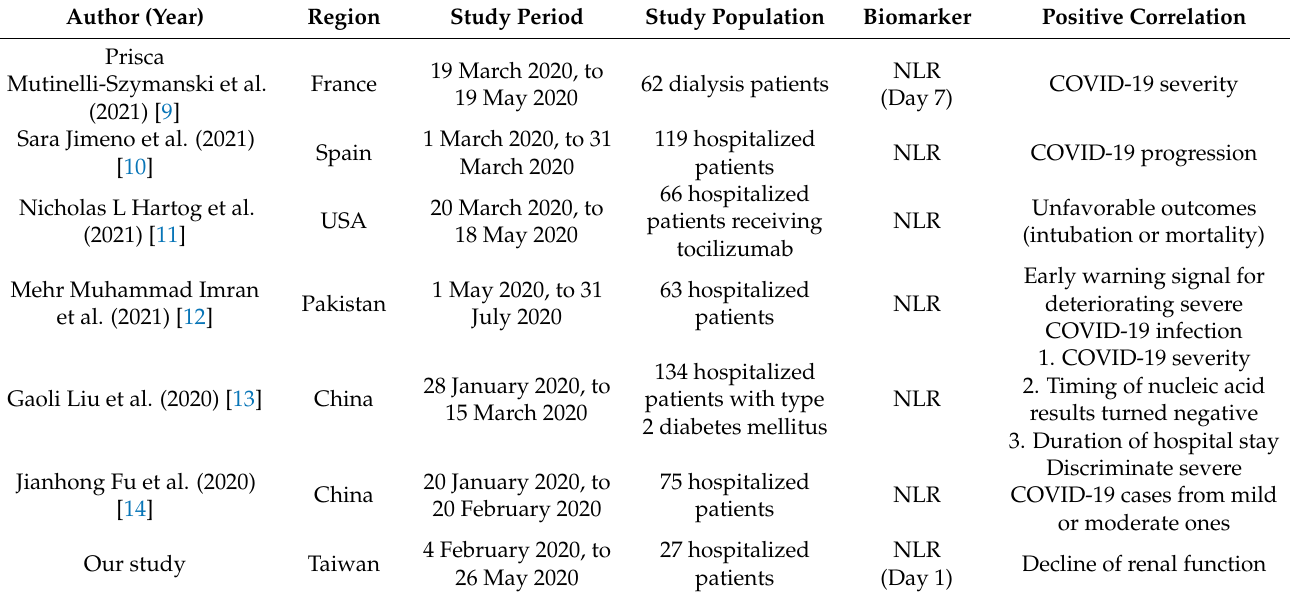
Table 5. The role of NLR in COVID-19.